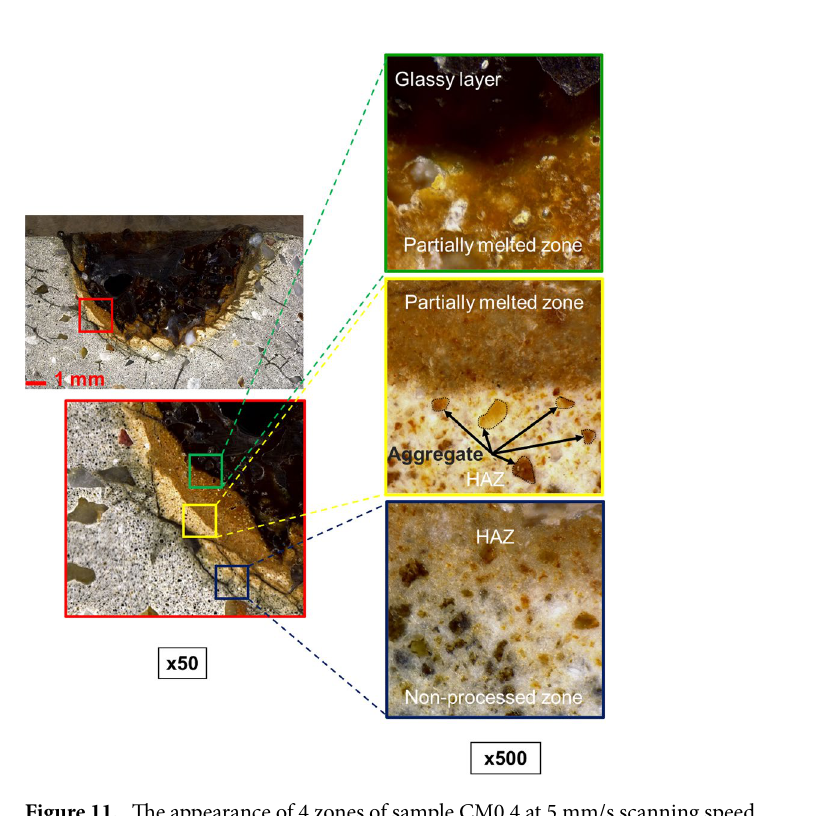
Figure 11. The appearance of 4 zones of sample CM0.4 at 5 mm/s scanning